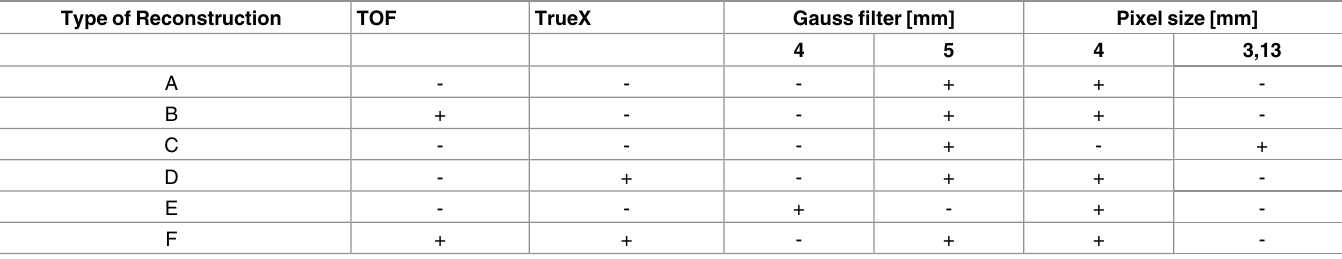
Table 1. Different settings of reconstruction methods for phantom measurements on Siemens Biograph mCT scanner. Type of Reconstruction